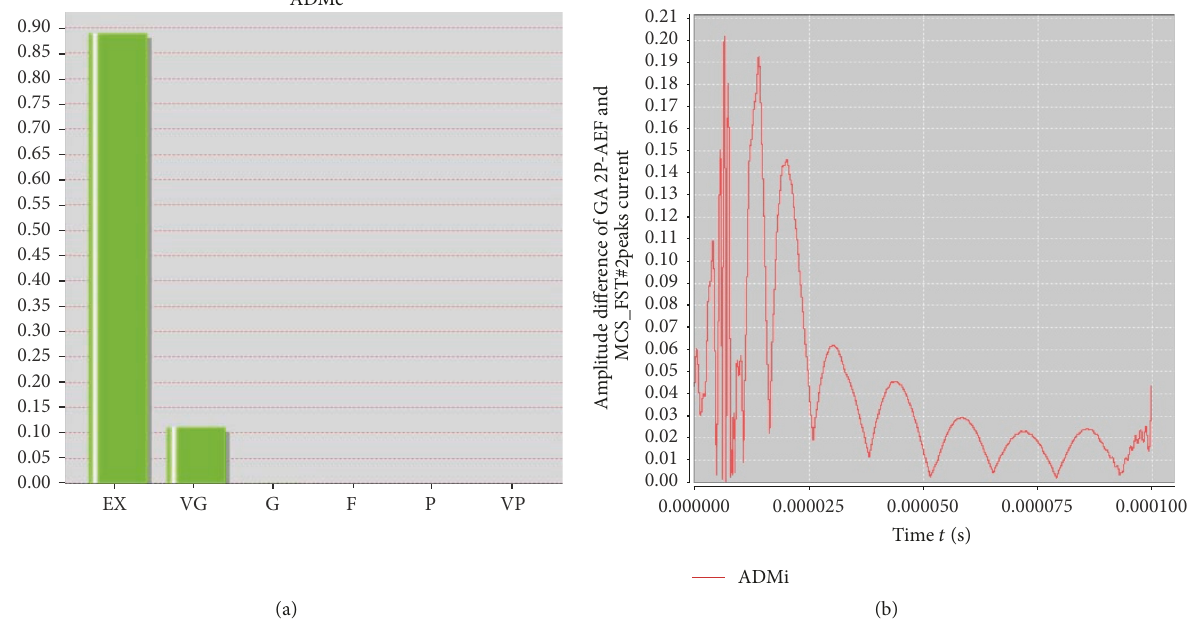
Figure 13: (a) ADMc and (b) ADMi obtained by FSV applied to MCS FST#2peaks results [20] and its approximation by 2P-AEF(2,1,2) using GA for parameters evaluation.